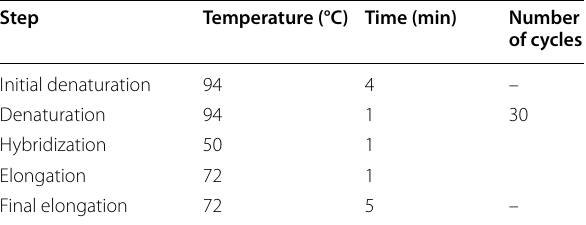
Table 3 PCR parameters for Mec